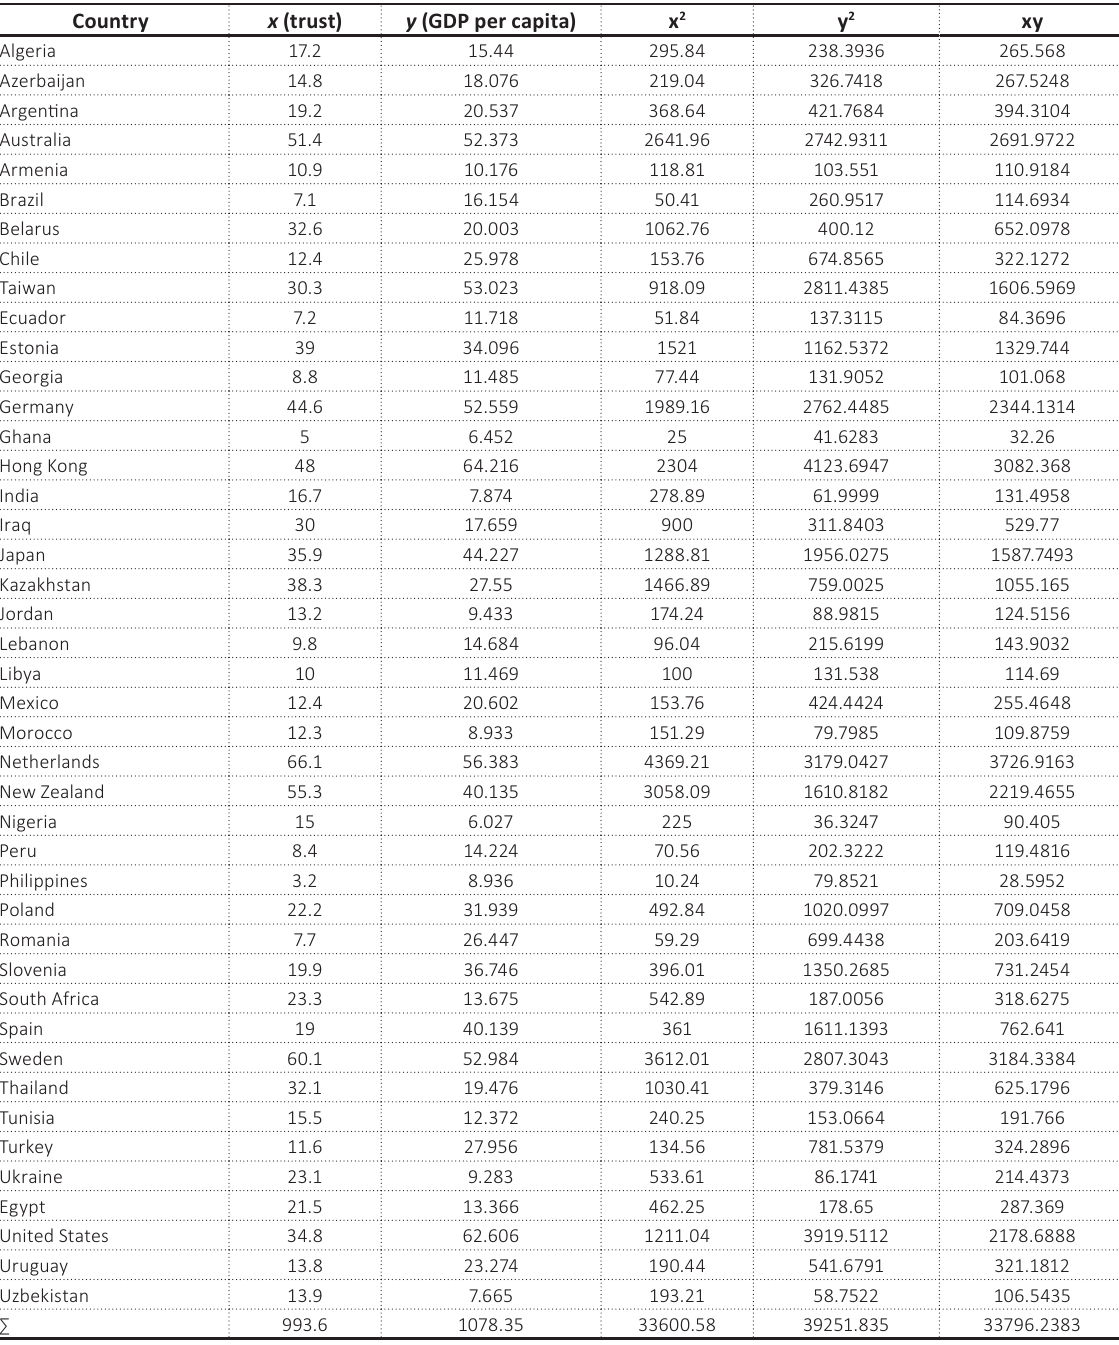
Table 3. Regression parameters